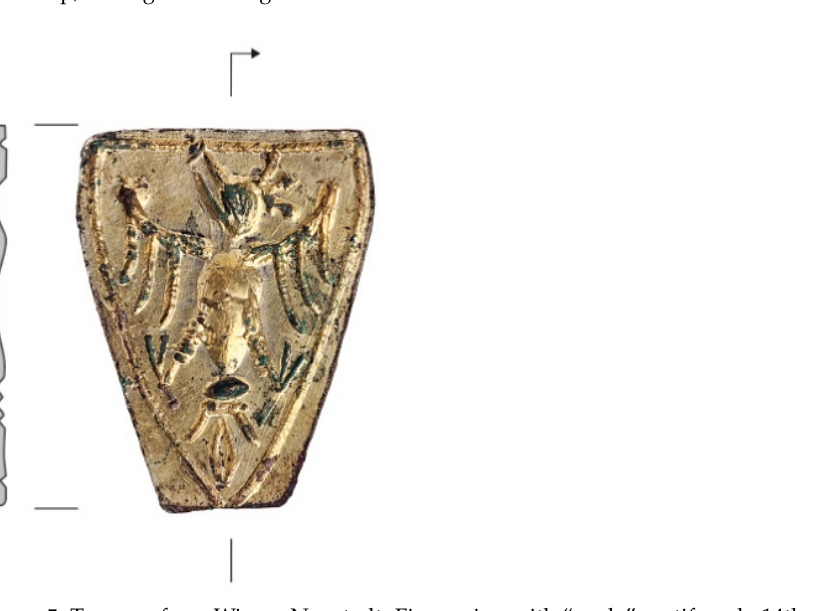
Figure 5. Treasure from Wiener Neustadt. Finger ring with “eagle” motif, early 14th century. Photo: Paul Kolp; editing: Franz Siegmeth.